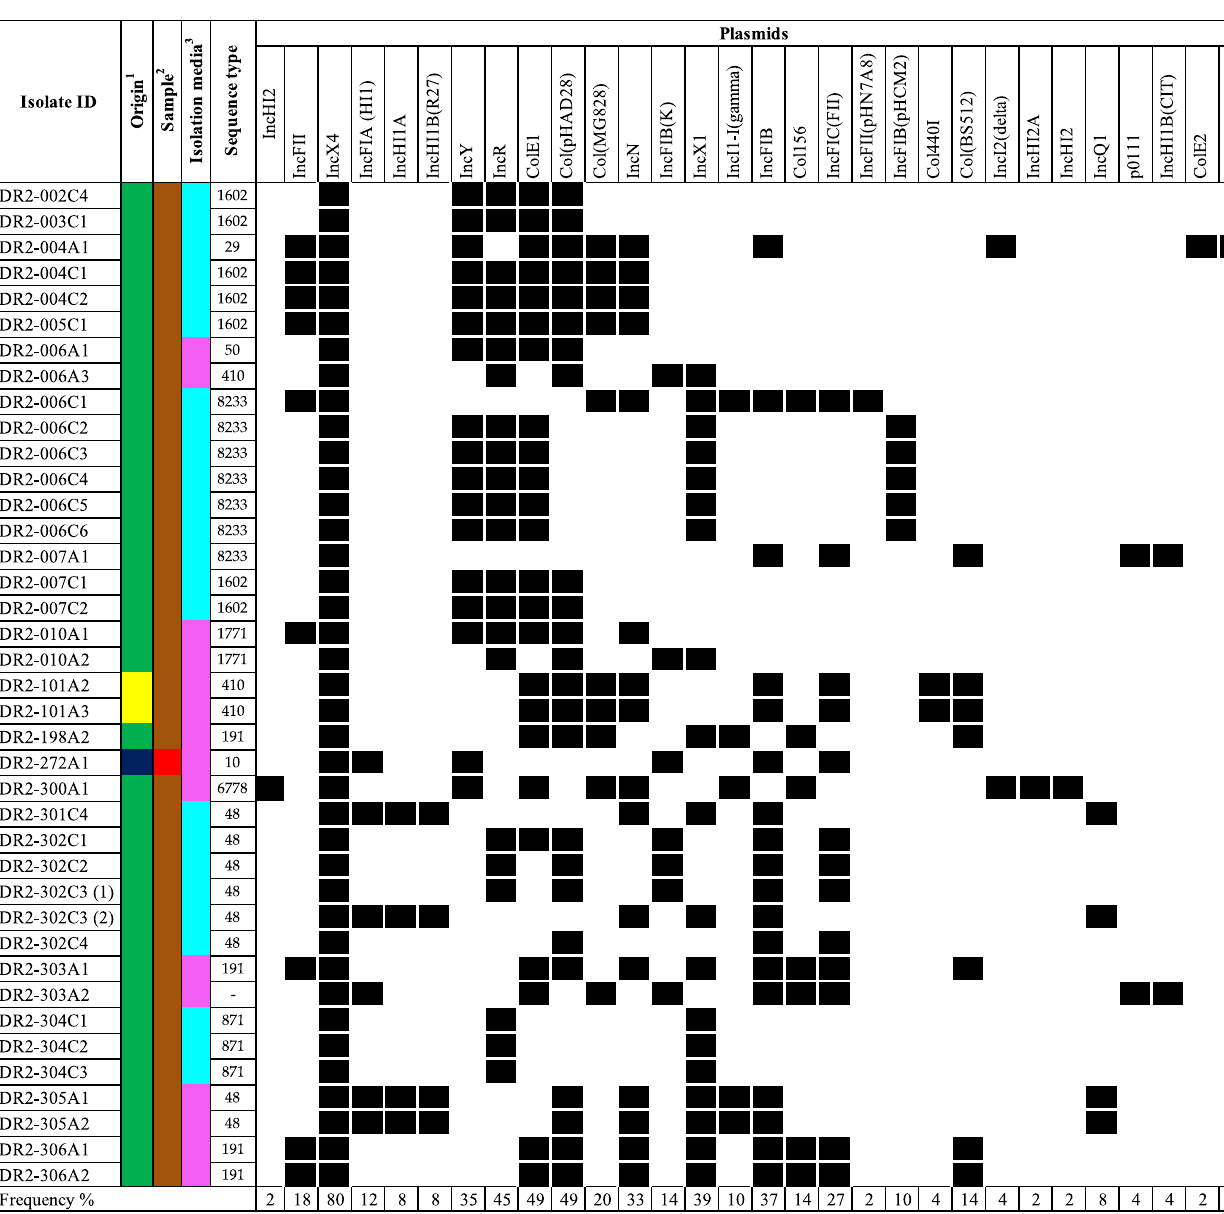
Figure 3. Black cells and white cells, indicate the presence or absence of plasmid replicon in the bacterial genome, respectively. For origin 1 , the colors navy blue, yellow, and green, represent beef cattle, chicken, and swine, respectively. For sample 2 , the colors brown and red represent feces and meat, respectively. For isolation media 3 , the colors pink and light blue represent VRBG0 and XLT4/BGS, respectively.